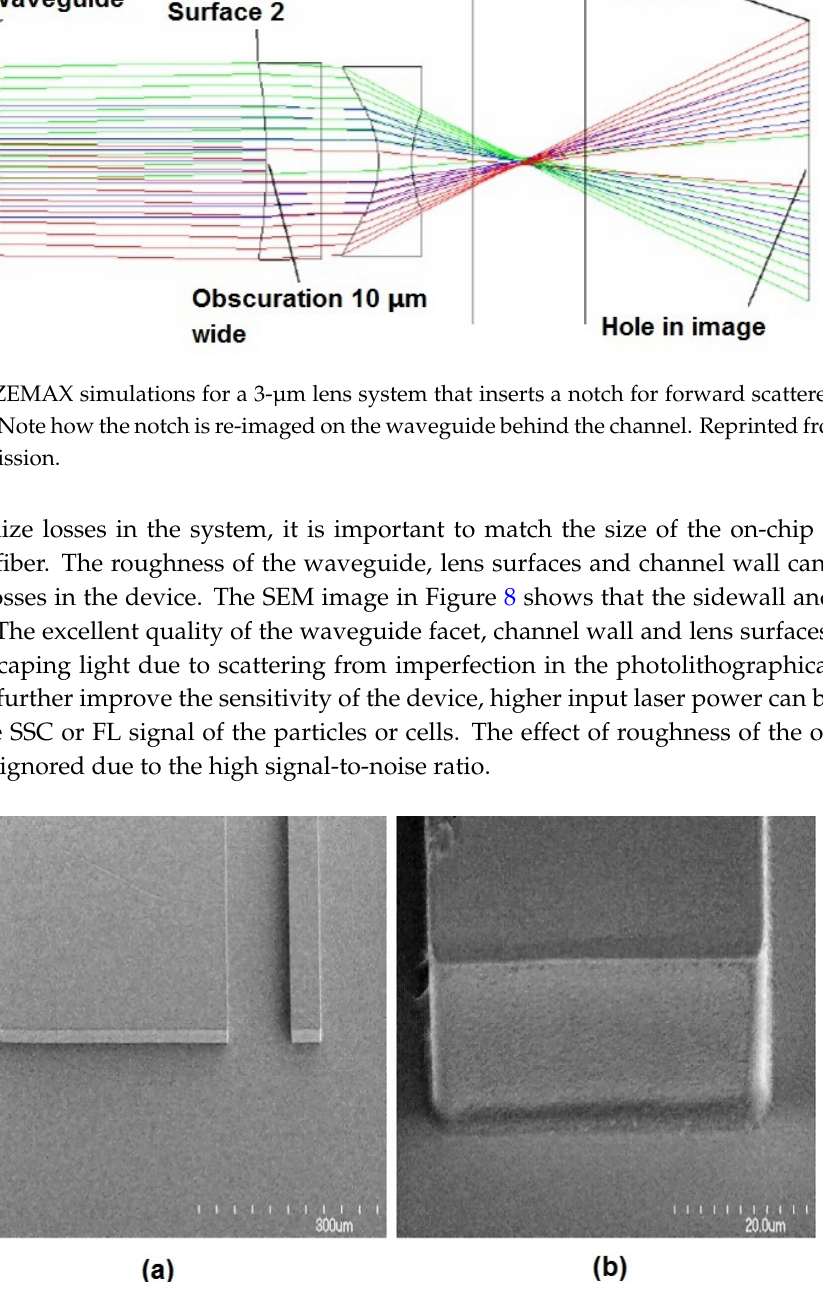
Figure 8. ( a ) SEM image of a waveguide facet. ( b ) A close-up SEM image of a waveguide facet showing the smooth optical coupling face. Reprinted from [65] with